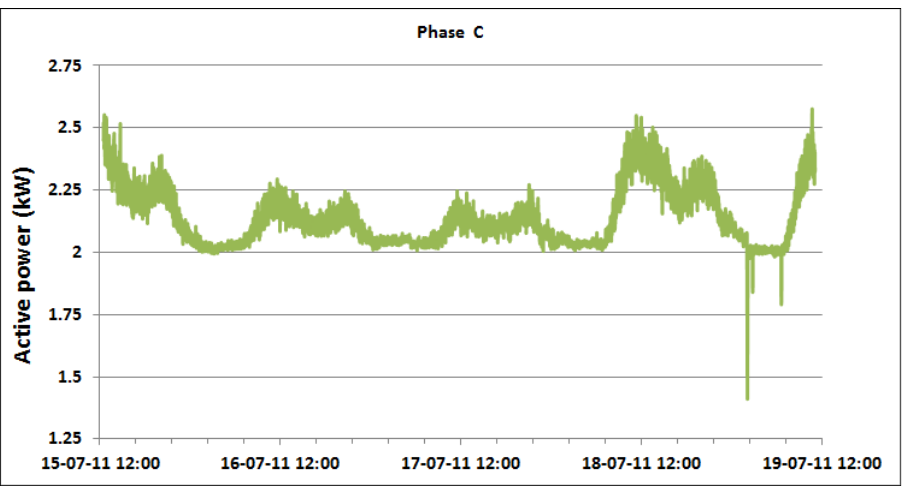
Figure 15. Active power of phase C for 15–19 July.